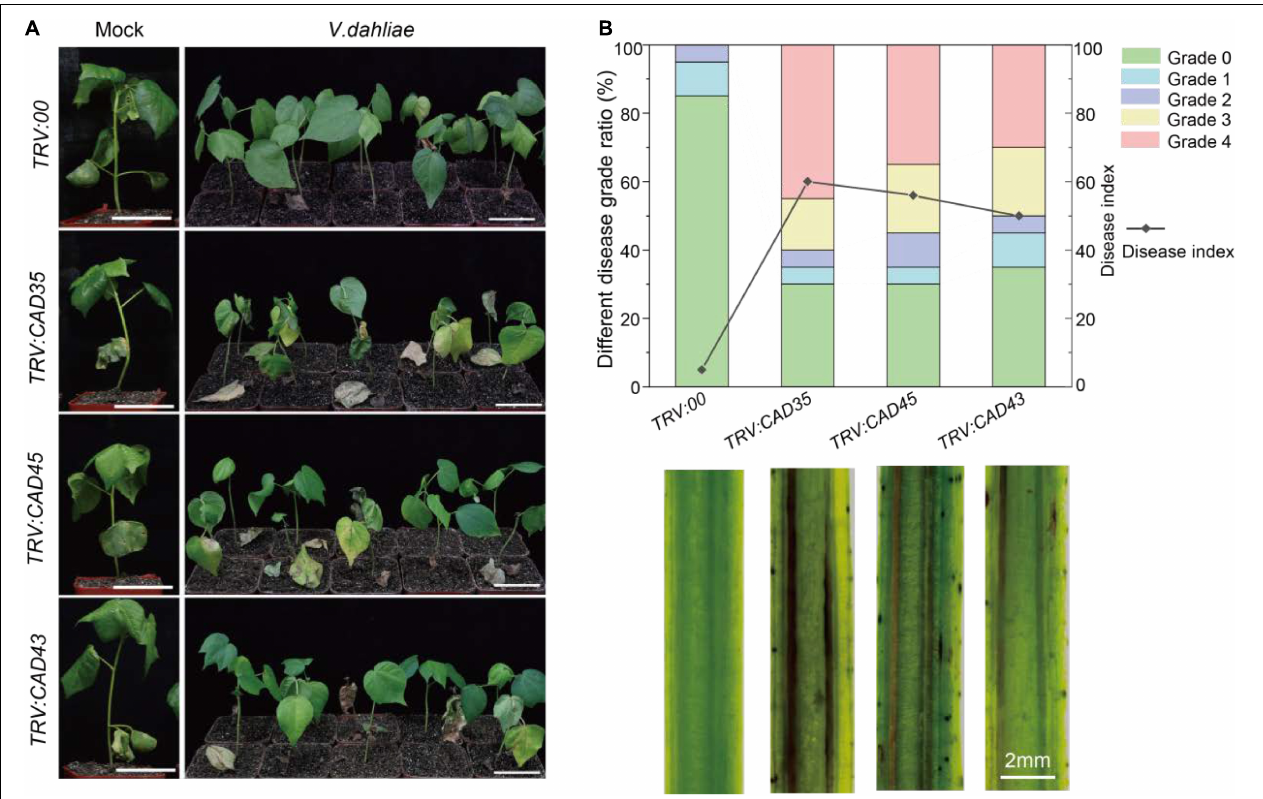
FIGURE 5 | Silencing of GhCAD35 , GhCAD45 , and GhCAD43 in Zhongzhimian 2 (Resistant to V. dahliae ) resulted in susceptible to V. dahliae . (A) Phenotypes of the TRV:00 , TRV:CAD35 , TRV:CAD45 , and TRV:CAD43 VIGS plants at 18 days post V. dahliae infection (dpi). (B) Ratio of different diseased grades and disease index for TRV:00 , TRV:CAD35 , TRV:CAD45 , and TRV:CAD43 VIGS plants at 18 dpi (upper panel); the images showing the longitudinal stem sections of TRV:00 , TRV:CAD35 , TRV:CAD45 , and TRV:CAD43 VIGS plants 18 dpi (lower panel). Two-weeks-old VIGS-plants were inoculated with V. dahliae at an inoculum of 1 × 10 7 spores/mL using the root-dipping method. n =